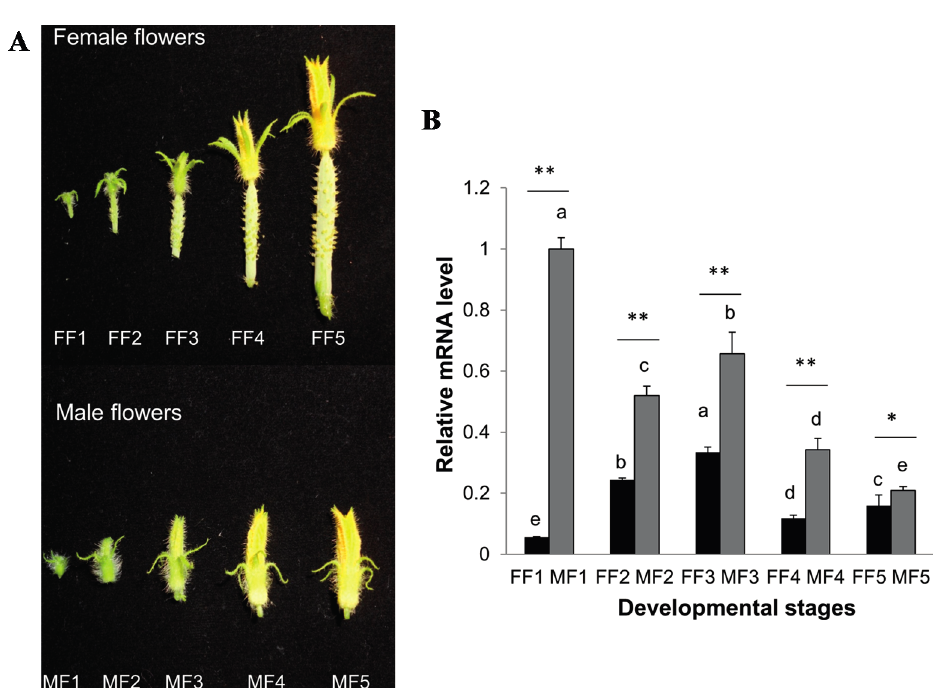
Figure 8. Expression patterns of CsCTR1 during different flower developmental stages. ( A ) Morphology of male flowers (MF) and female flowers (FF) at five developmental stages, which were separated on the basis of the corolla length. MF1/FF1 = (2.5 ± 1) mm, MF2/FF2 = (5 ± 1) mm, MF3/FF3 = (9 ± 2) mm, MF4/FF4 = (15 ± 2) mm, MF5/FF5 = (20 ± 2) mm; ( B ) Relative expression of CsCTR1 normalized to the cucumber Actin3 gene used as internal control in female flowers and male flowers at different developmental stages. Each result was the average of three independent biological replicates. Error bars on each column indicate standard deviation. The statistical significance was determined by Duncan’s multiple comparison tests and Student’s t -test. Different letters above bars indicate significant differences ( p < 0.05). The same letter indicates no significant difference ( p < 0.05). * p < 0.05, ** p < 0.01 by the Student’s t